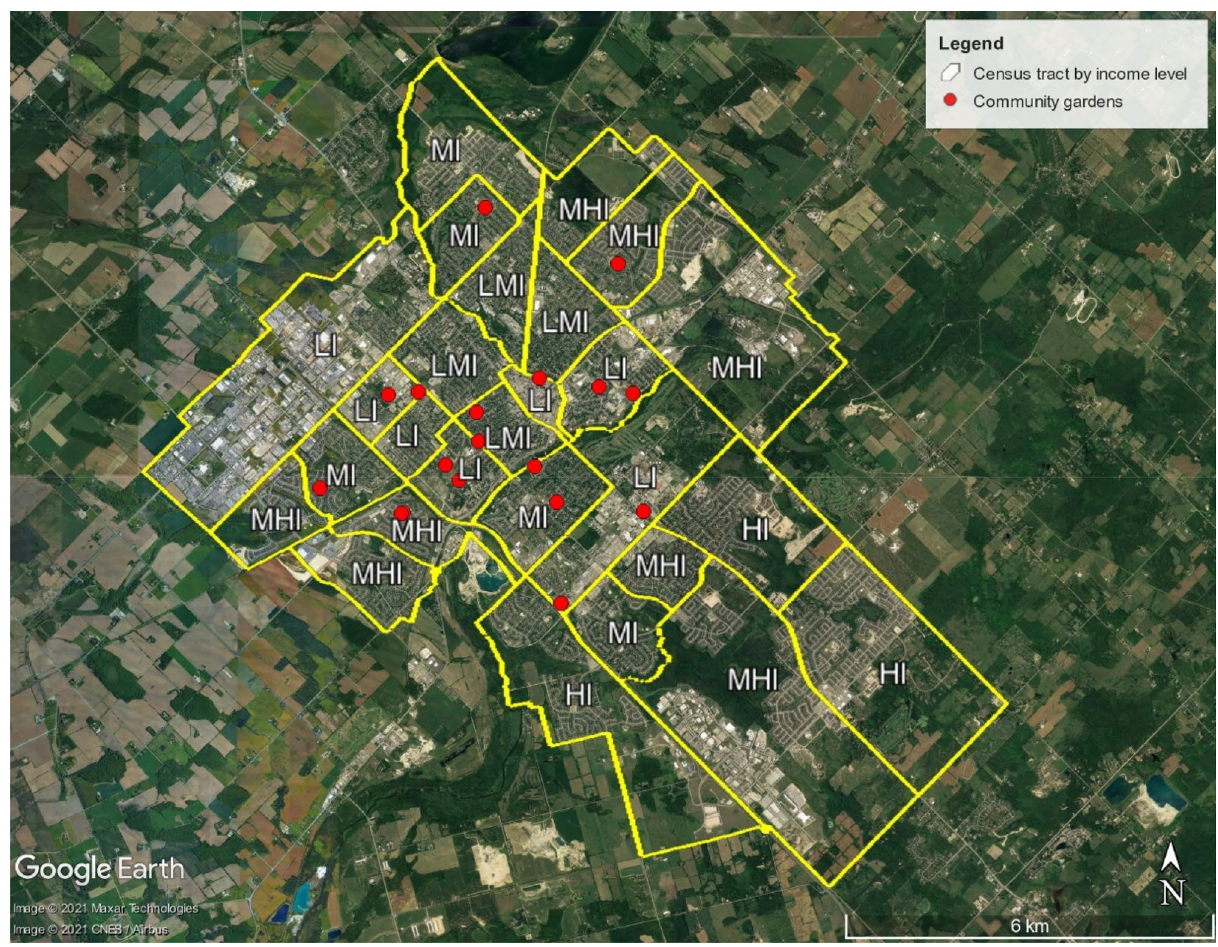
Figure 1. Map of the study area and sampling points. The map was prepared by using the “Places” tool in Google Earth Pro (https:// www. google. com/